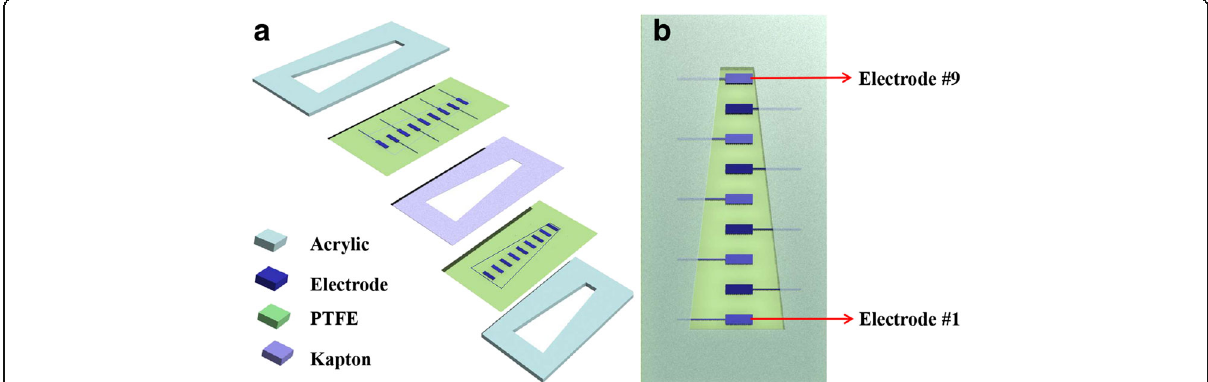
Fig. 2 Structural design of the bionic membrane sensor. a The 3D view of the major components of the device for frequency selectivity. They are glued together, and only the stretchy PTFE membranes surrounded by the trapezoidal slit can vibrate freely under the sound stimulation. b The top view of the sensor. The electrodes, made of silver deposition, are numbered from electrode #1 to #9